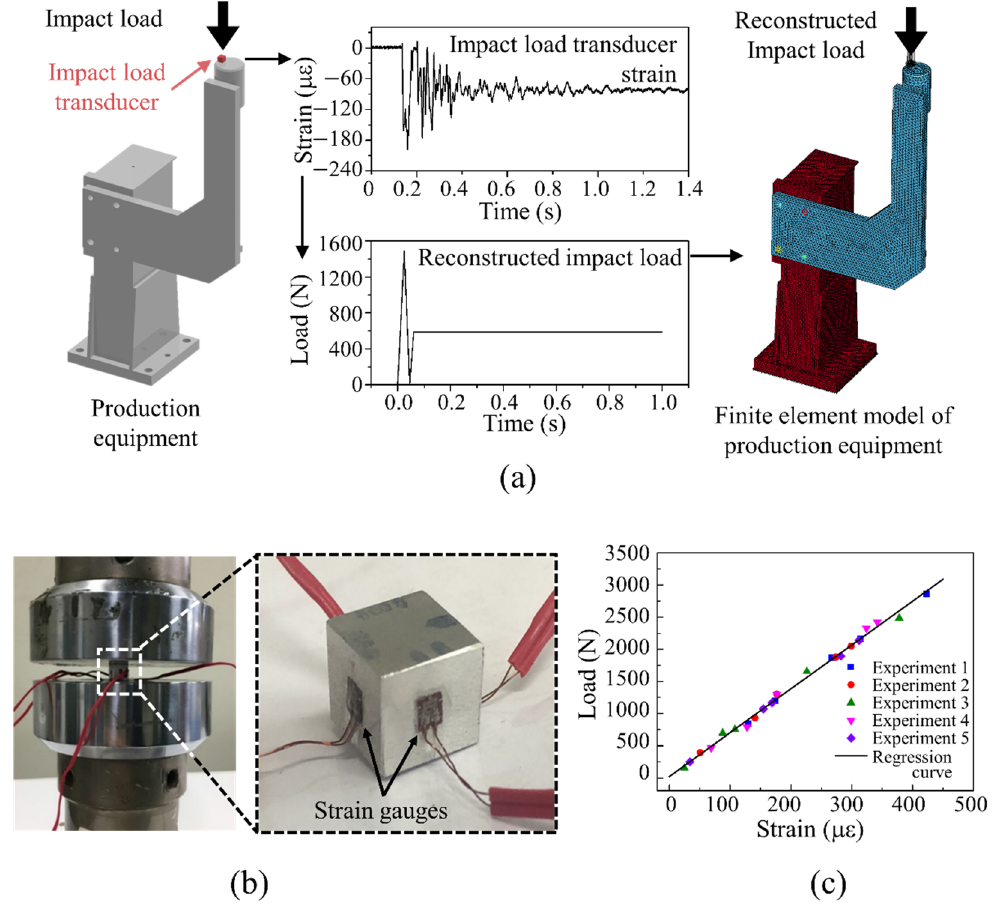
Figure 1. Illustration of method to identify the external impact load acting on production equipment. ( a ) Schematic of process for determining impact load and application of reconstructed impact load; ( b ) procedure for calibrating impact load transducer using uniaxial compression test; ( c ) model for conversion from strain signal to impact load.